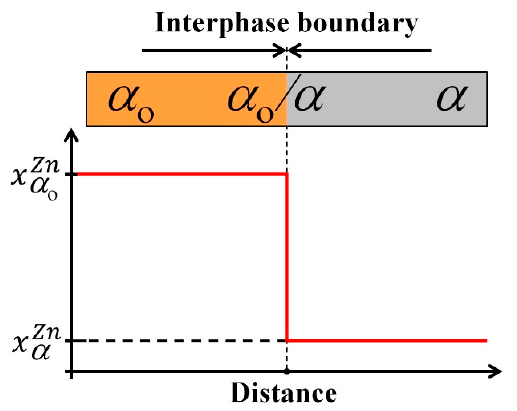
Figure 3. Sharp interface concept used to discretise the chemical discontinuity across the reaction front.